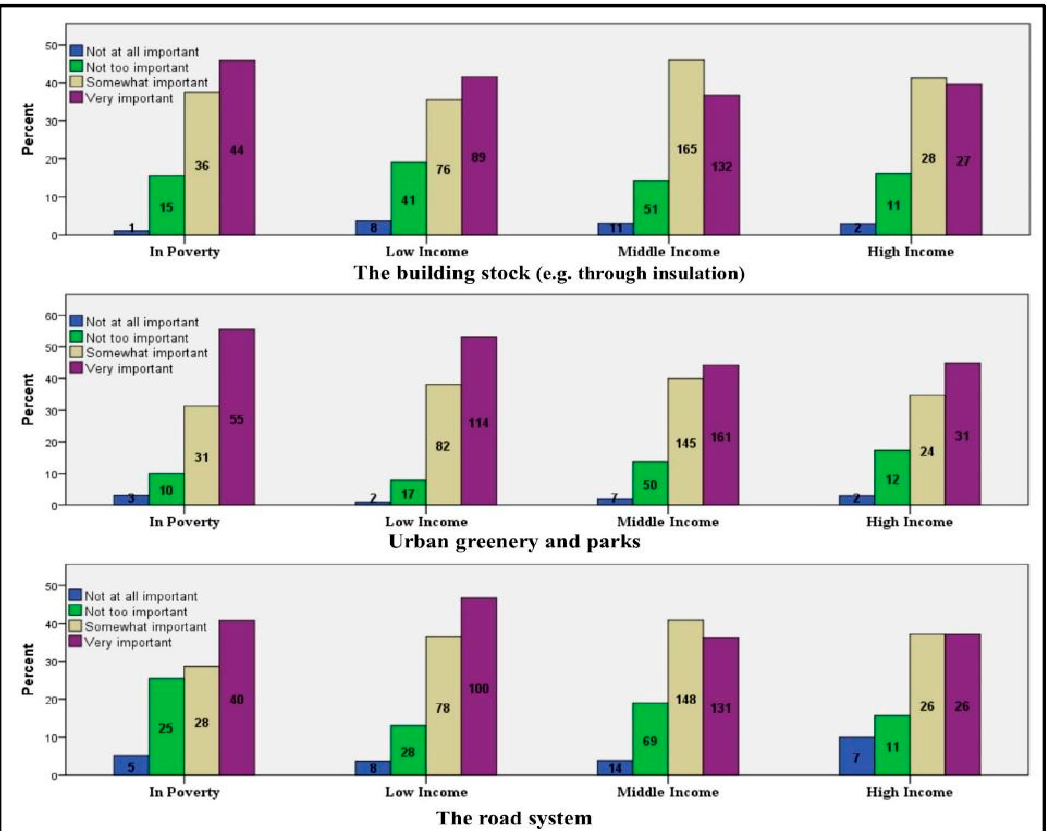
Figure A4. Importance of different urban sectors in heat wave adaptation based on income groups’ perception (the numbers inside the bars represent the number of responses in the data base ).